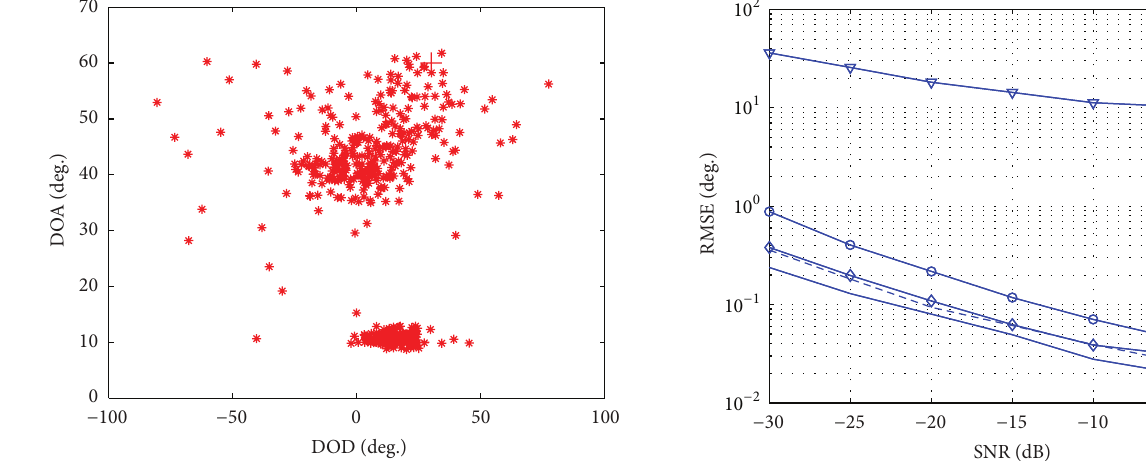
Figure 3: Estimation results of the standard ESPRIT method for three high speed targets.